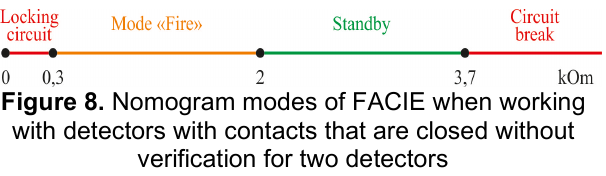
Figure 11. States of non-address FACIE depending on the resistance of the